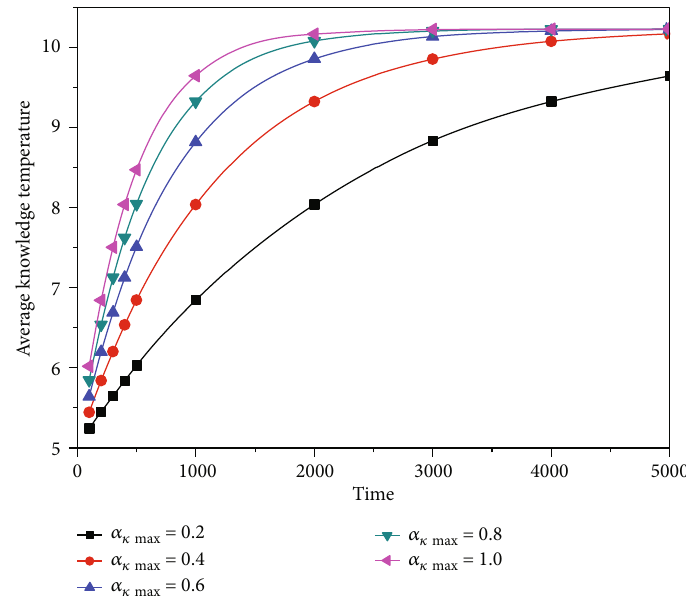
Figure 1: Organization-mean knowledge temperature on di ff erent absorption capacity coe ffi